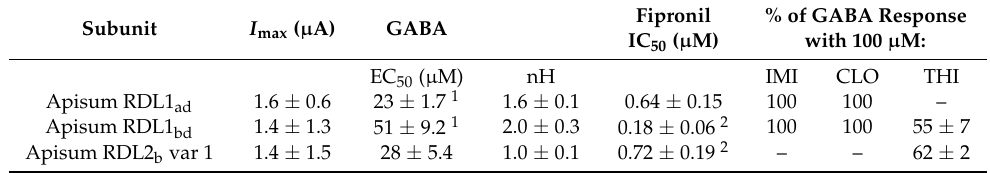
Figure 5. Responses to GABA in X. laevis oocytes expressing Apisum RDL. ( a ) Representative current trace of a GABA concentration response curve showing responses to GABA from 0.1–250 μ M for Apisum RDL1 bd ; ( b ) GABA concentration response curves obtained for Apisum RDL1 ad , Apisum RDL1 bd , and Apisum RDL2 b variant 1. Data were normalised to the maximal response (250 μ M). Data is the mean ± SEM from n = 4–5 oocytes from ≥ 3 different frogs. Table 2. Effects of GABA on membrane currents from X. laevis oocytes expressing A. pisum RDL, with maximum amplitude ( I max ), EC 50 and hill coefficient (nH) displayed. The I max was obtained from the initial 250 µ M GABA response measured from eggs clamped at − 60 mV. Also shown are the effects of fipronil and the neonicotinoids imidacloprid (IMI), clothianidin (CLO), and thiacloprid (THI) on GABA EC 50 induced membrane currents. IC 50 values are shown for fipronil, as well as the fraction of response to GABA at EC 50 after exposure to 100 µ M neonicotinoid. All data are the mean ± SEM of 4-5 oocytes from ≥ 3 different frogs. [–] indicates that this value was not